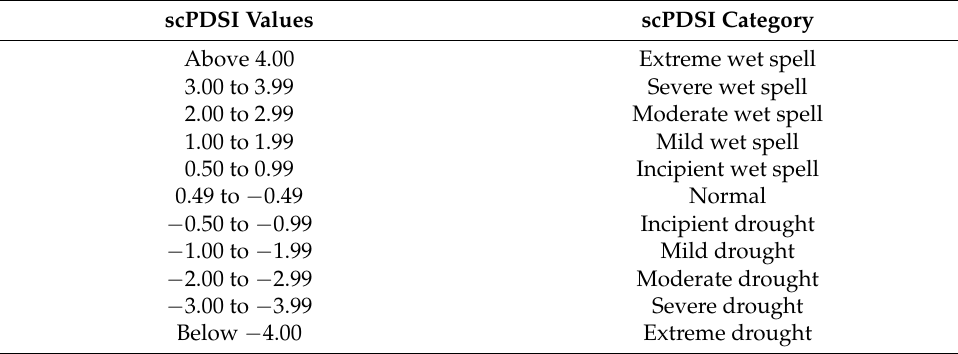
Table 2. Drought classification after Wells et al.